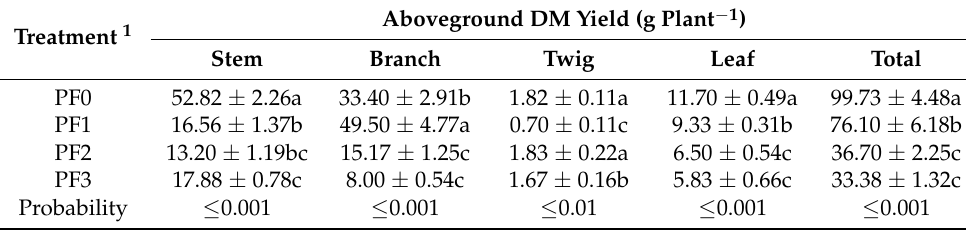
Table 1. Aboveground dry matter (DM) productivity of S. sesban as affected by pruning frequency. Treatment 1